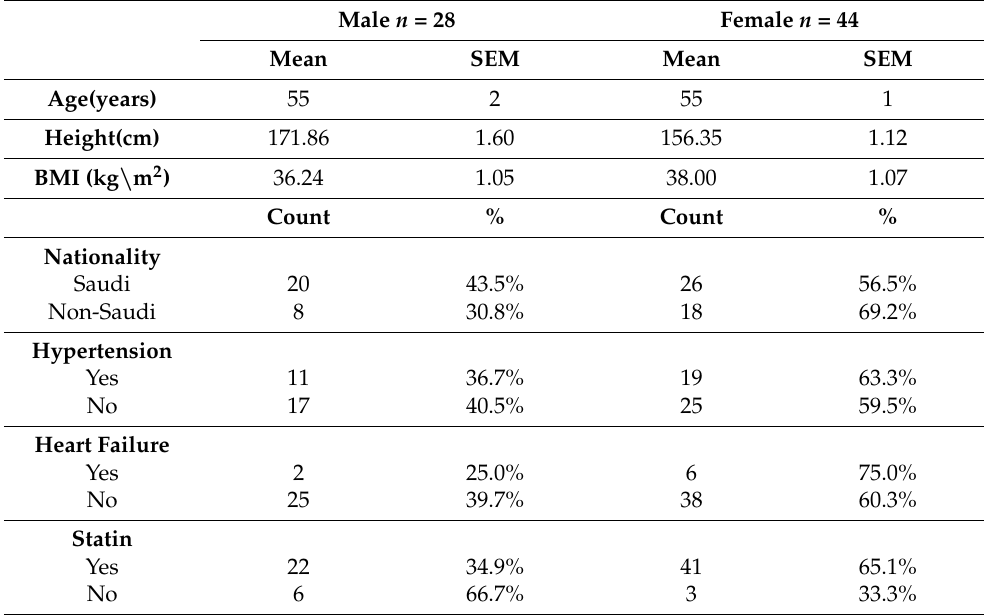
Table 1. Demographic, anthropometric, and clinical characteristics of the studied groups.